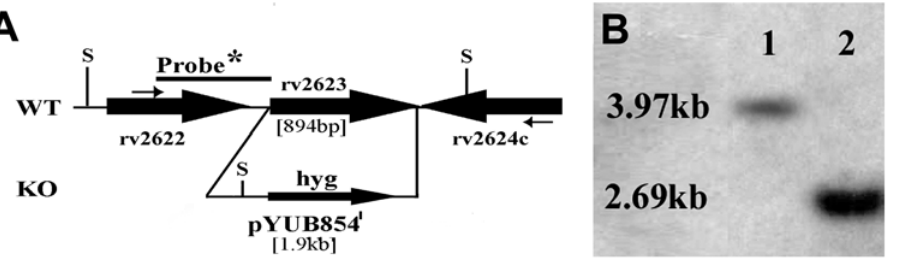
Figure 1. Generation of D rv2623M.tuberculosis strain. (A) Genomic organization of the rv2623 gene locus. Genes appear as large arrows in their native orientation. Small arrows represent forward and reverse primers used for long range PCR. Sizes of the rv2623 deletion and hyg -insertion are indicated. The location of the radiolabeled probe (black bar) as well as relevant Sph1 sites (S) is indicated as they pertain to the Southern blot. (B) An autoradiograph of the Southern blot shows radiolabeled Sph1 fragments from the wild type (lane 1) and D rv2623 strain (lane 2). The sizes indicated represent those expected for wild type and the deletion mutant.